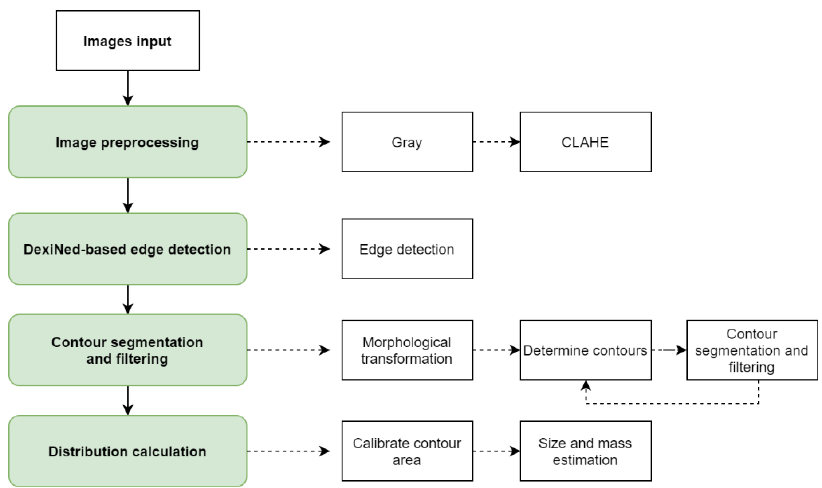
Figure 1. A flowchart of the proposed processes of ore size distribution estimation.